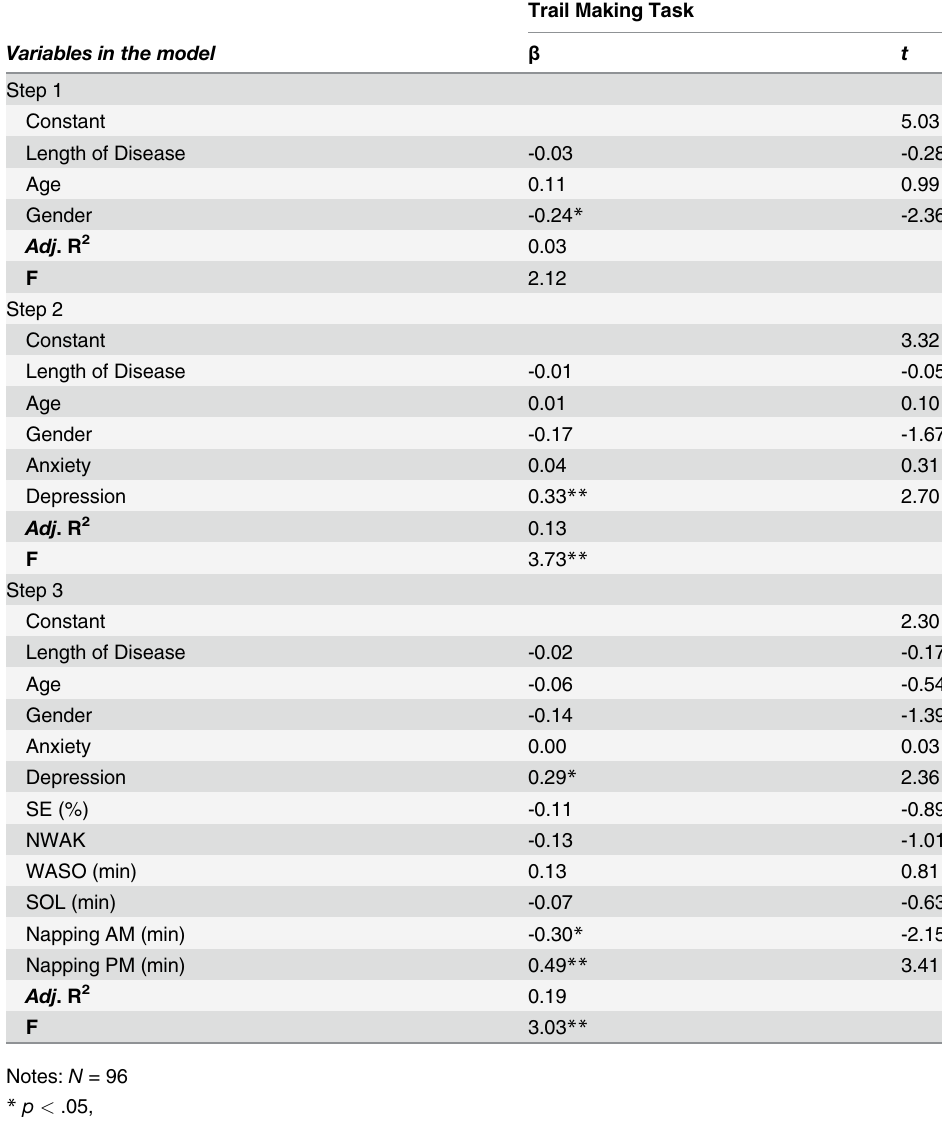
Trail Making Task